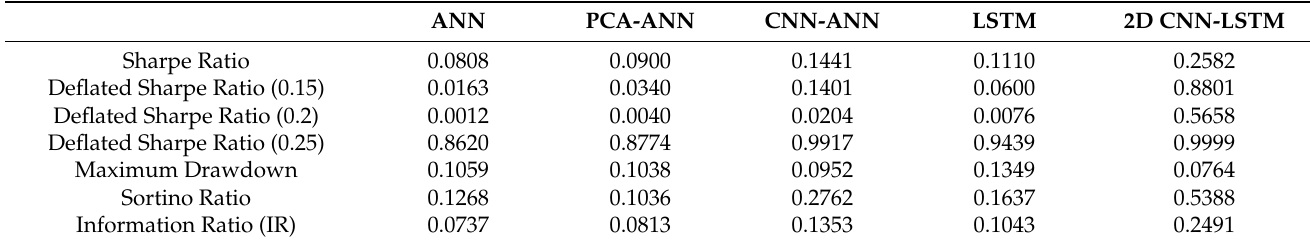
Table 13. The Amount of Each Measure with One-Day-Ahead Forecast.